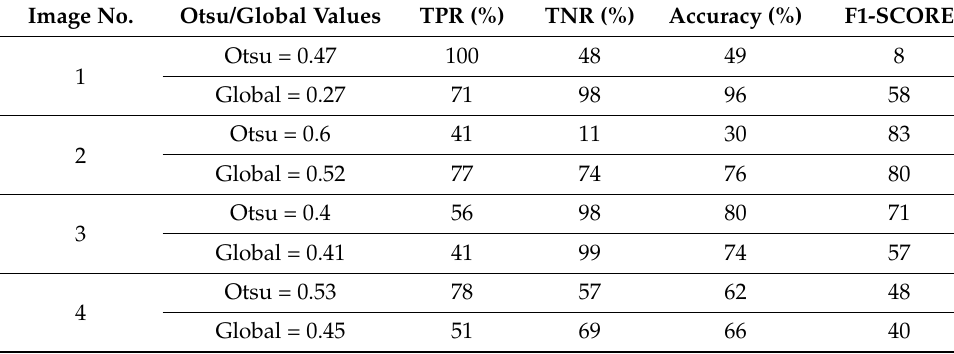
Table 7. Comparison of Otsu and global